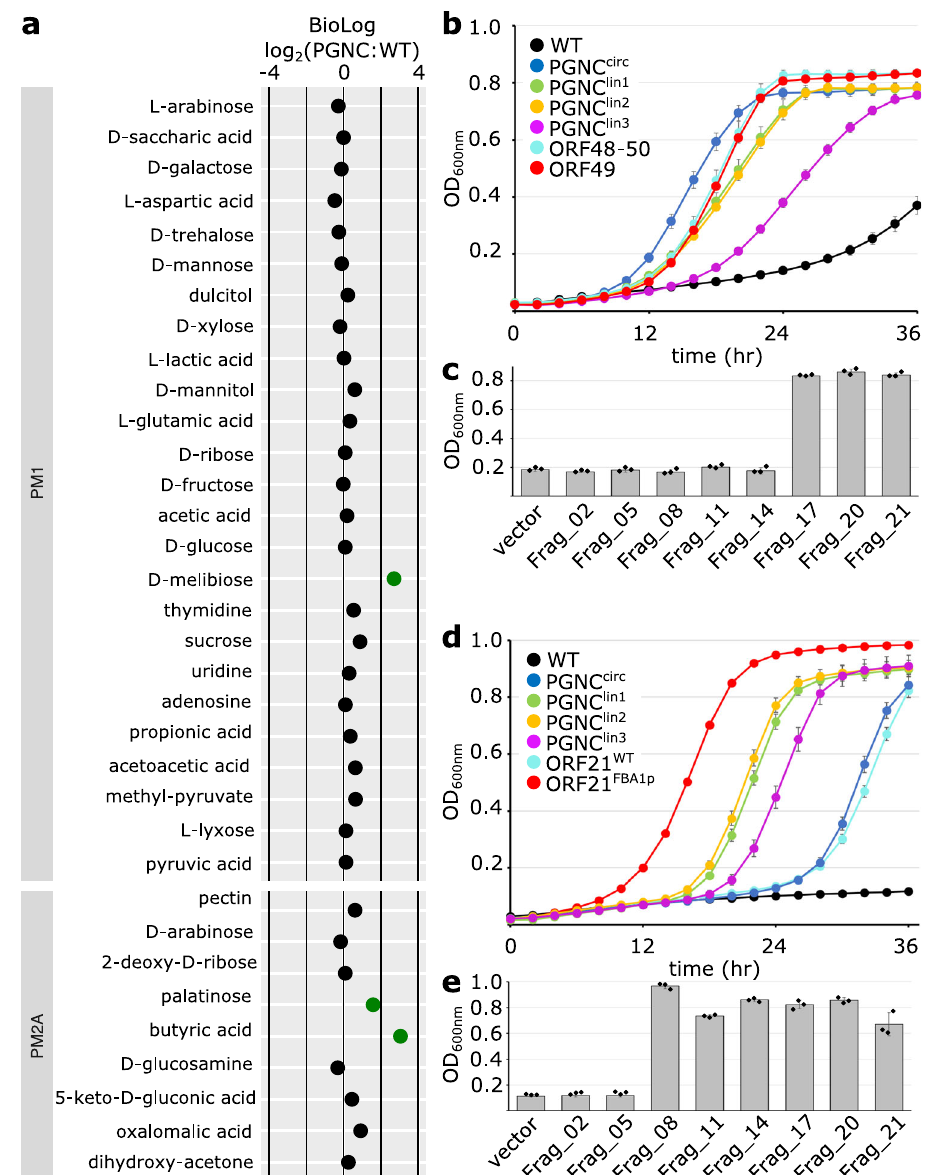
Fig. 3 The PGNC element expands the phenotypic repertoire of BY4742. a BioLog results for the carbon-source utilization plates, PM1 and PM2A. Values are presented as log 2 normalized (PGNC:WT) observations of maximal respiration rate, with increased growth rates highlighted in green. b Growth kinetics for PGNC strains with palatinose as a sole carbon source. c Identifying the palatinose-utilizing region of the PGNC via 24 h end-point growth assays of intermediate PGNC elements. d Growth kinetics for PGNC strains with melibiose as a sole carbon source. e Identifying the melibiose-utilizing region of the PGNC via 24 h end-point growth assays of intermediate PGNC elements. All growth kinetic data are presented as mean values + / − SD, based upon values obtained from three independent biological replicates. Source data are provided as a Source Data fi